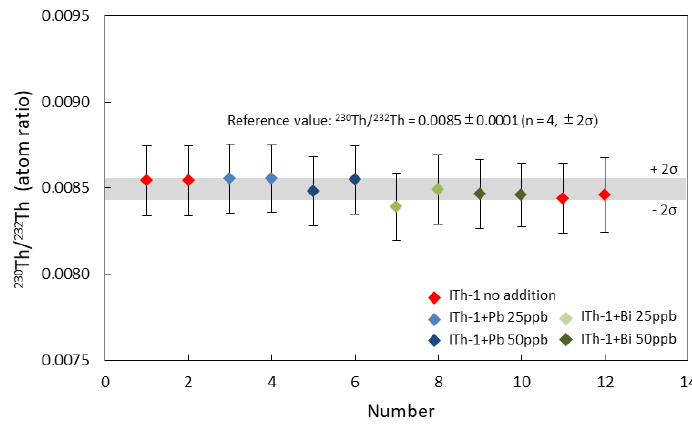
Figure 3. Effects of Pb and Bi on 235 U/ 233 U and δ 234 U of IU-1.